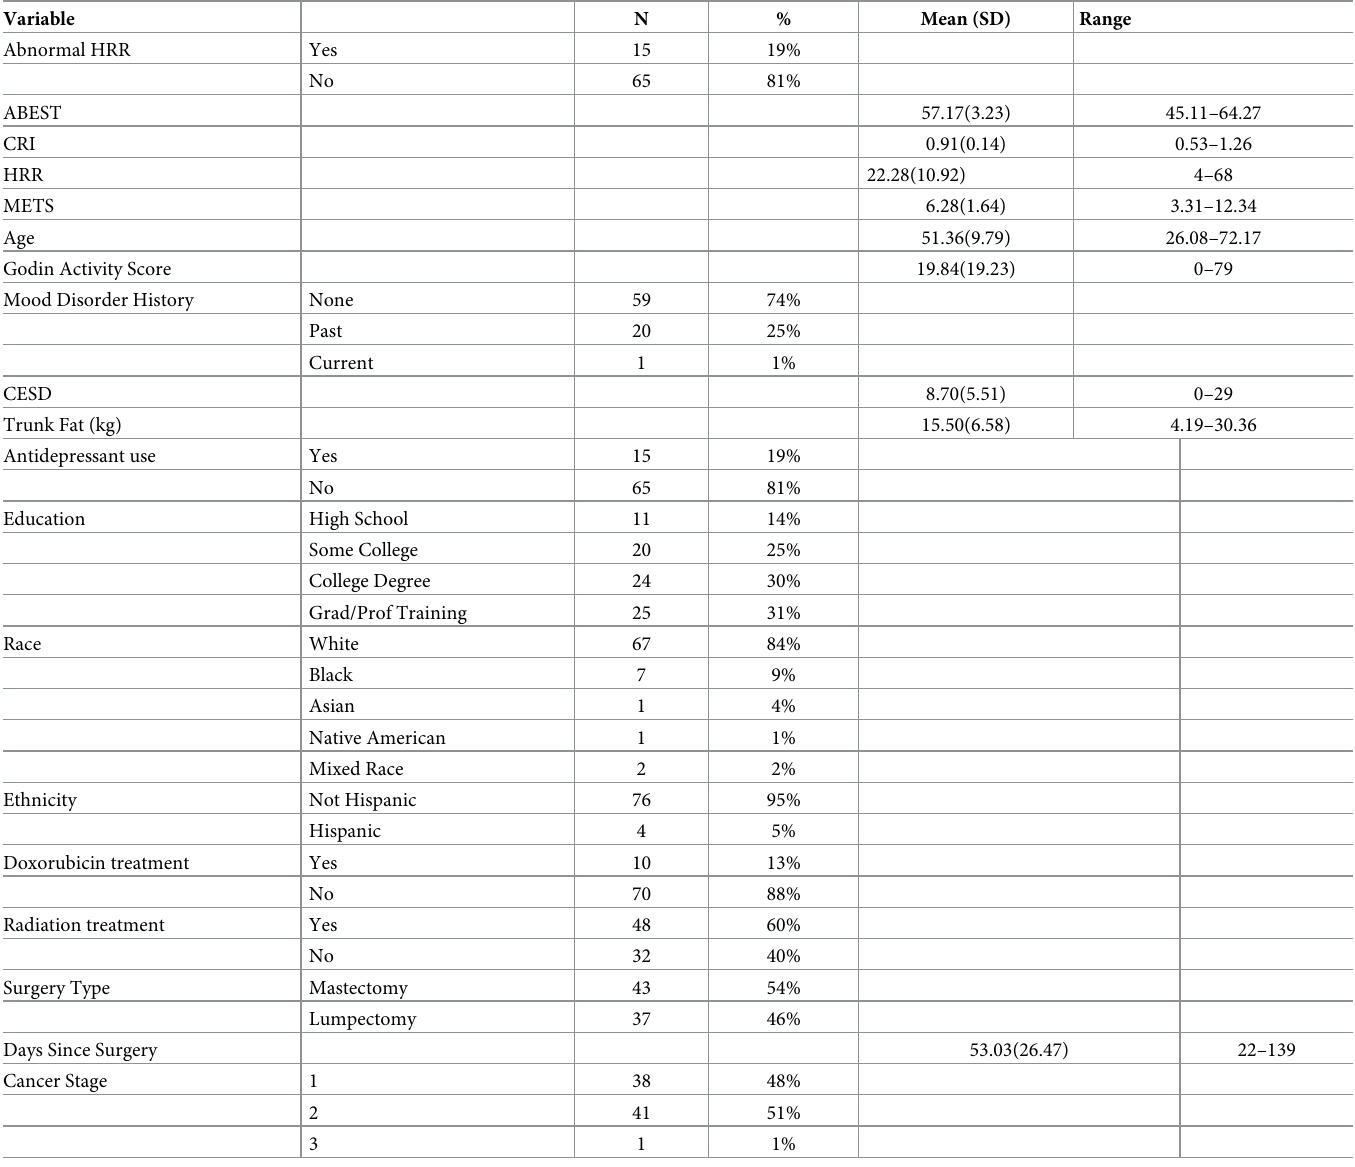
Table 1. Demographics of analysis sample at Visit